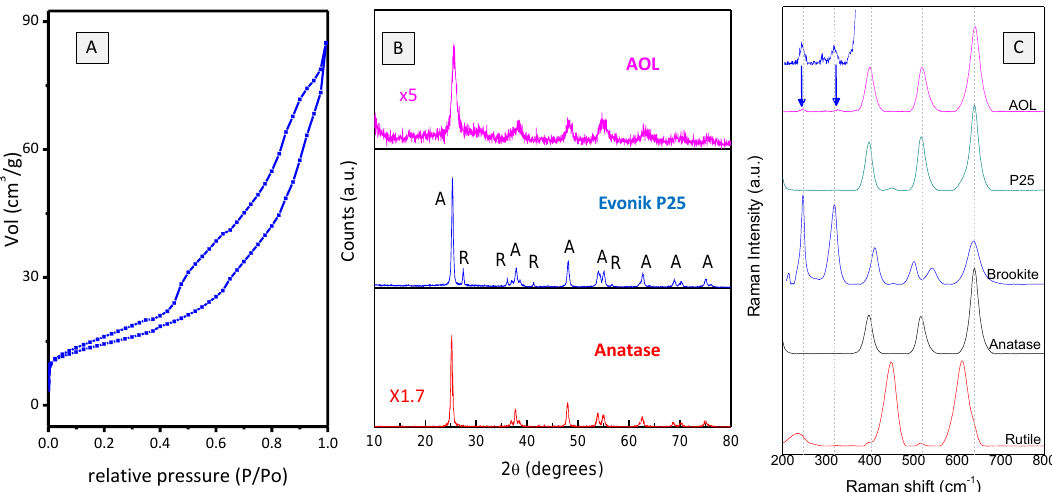
Figure 5. Characterization of AOL. ( A ) Nitrogen adsorption-desorption isotherm. ( B ) XRD pattern. Those patterns of Evonik P25 and Anatase have also been included for comparison. Anatase (A) and Rutile (R) peaks are marked for Evonik P25. ( C ) Raman spectra. For comparative purposes, spectra of brookite and rutile reference materials have also been included. Spectrum of brookite was obtained from RRUFF database (https://rruff.info/brookite/) whereas that of rutile corresponds to a reference material from Sigma-Aldrich (Sigma-Aldrich, Darmstadt, Germany).